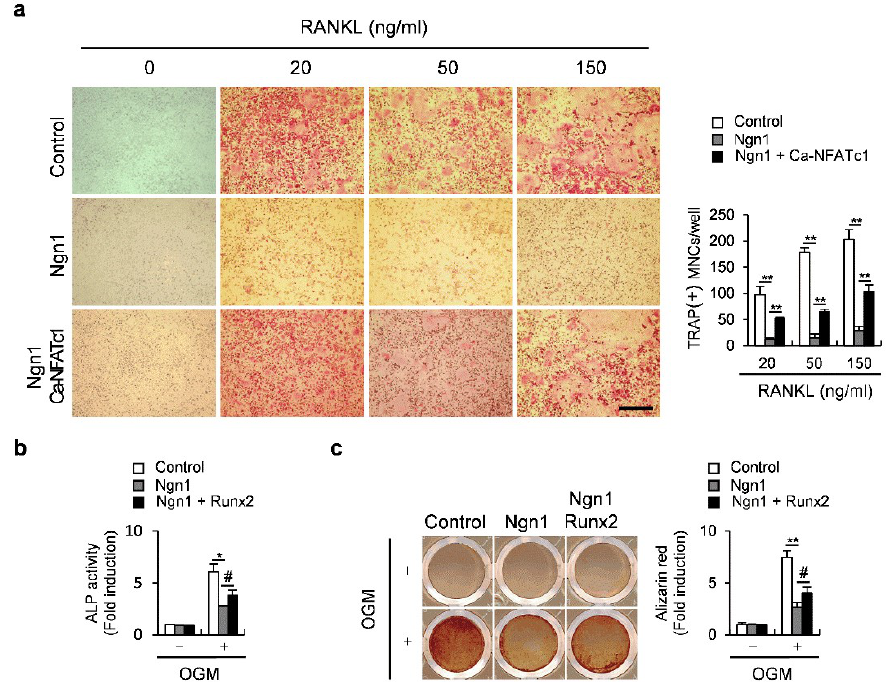
Figure 4. The overexpression of NFATc1 or Runx2 partially rescued the inhibitory effects of Ngn1 on osteoclastogenesis or osteoblastogenesis, respectively. ( a ) BMMs overexpressing Ngn1 or Ngn1 and Ca-NFATc1 were generated via retroviral infection and subsequently cultured with M-CSF and RANKL for 3 days. TRAP-stained cells (left panel) and the number of TRAP-positive multinucleated cells (right panel), scale bar: 200 µ m. ( b , c ) Osteoblast precursor cells overexpressing Ngn1 or Ngn1 and Runx2 were generated via retroviral infection and subsequently cultured with OGM. ( b ) Levels of ALP in cells cultured for 3 days. ( c ) Cells were cultured for 6 days, stained with alizarin red (left panel), and those positive for alizarin red were quantified (right panel). # p < 0.05, * p < 0.01, ** p < 0.001 vs. control.